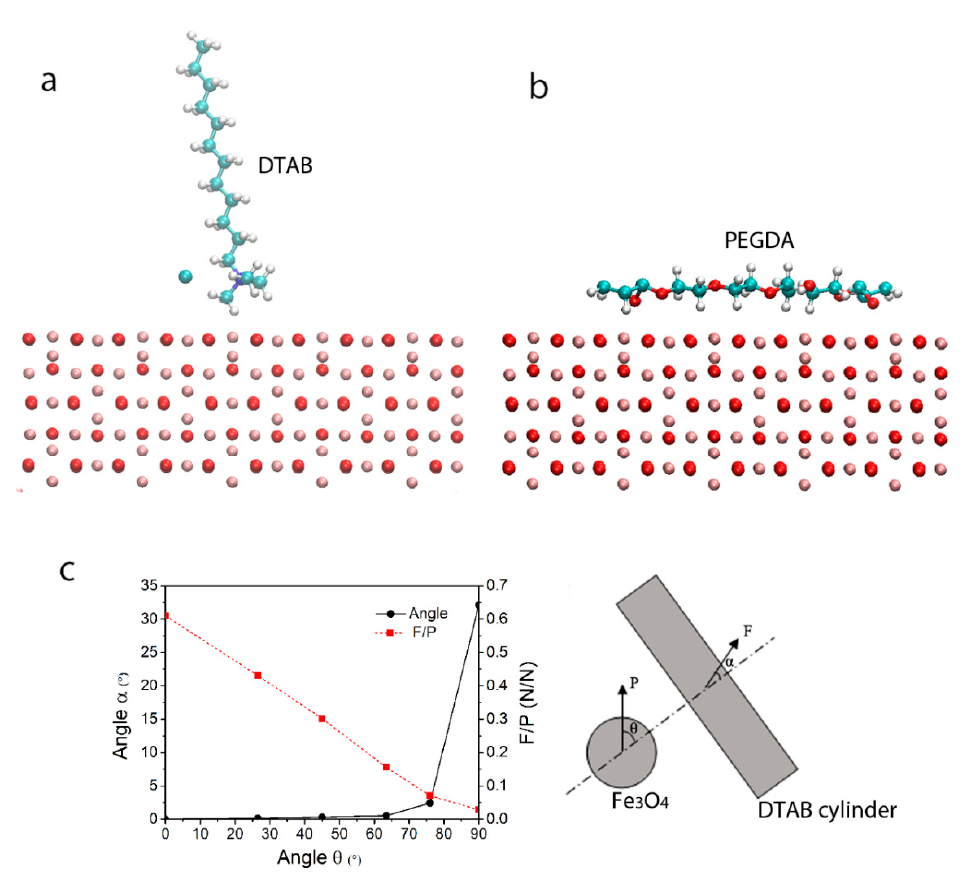
Figure 4. MD simulation results. The side view of the interactions of ( a ) the head group of DTAB (The DTAB body repulse to the Fe 3 O 4 surface); and ( b ) PEGDA with (001) surface of magnetite. The Fe atoms in ochre, O in red, C in cyan, N in blue, H in white, and iodine ion in isolated cyan. ( c ) Magnitude and direction of force transfer from magnetite particle to the structured DTAB molecules. θ is the angle of magnetite particle force with a constant magnitude P . α is the angle of the force on DTAB cylinder, F (magnitude is F ). Both angles are measured from the planes normal to the cylinder axis.